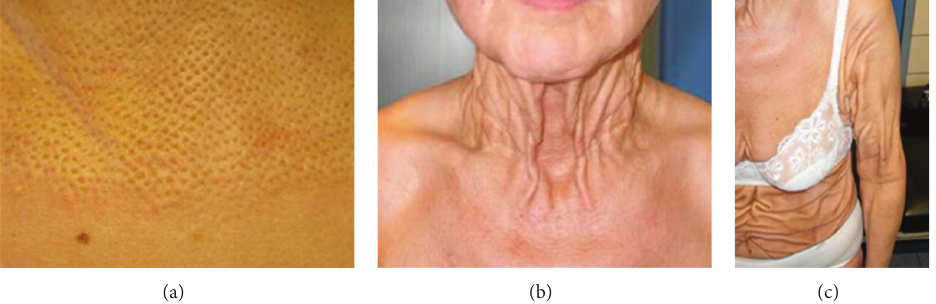
F 6: Clinical features of the PXE-like disease with coagulation factor de�ciency. �ypical cutaneous peau d�orange lesions (a) may be the